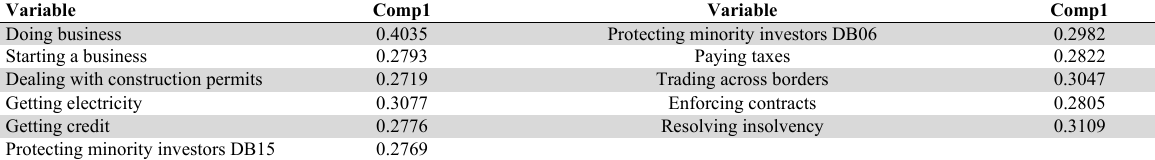
Factor pattern of the first